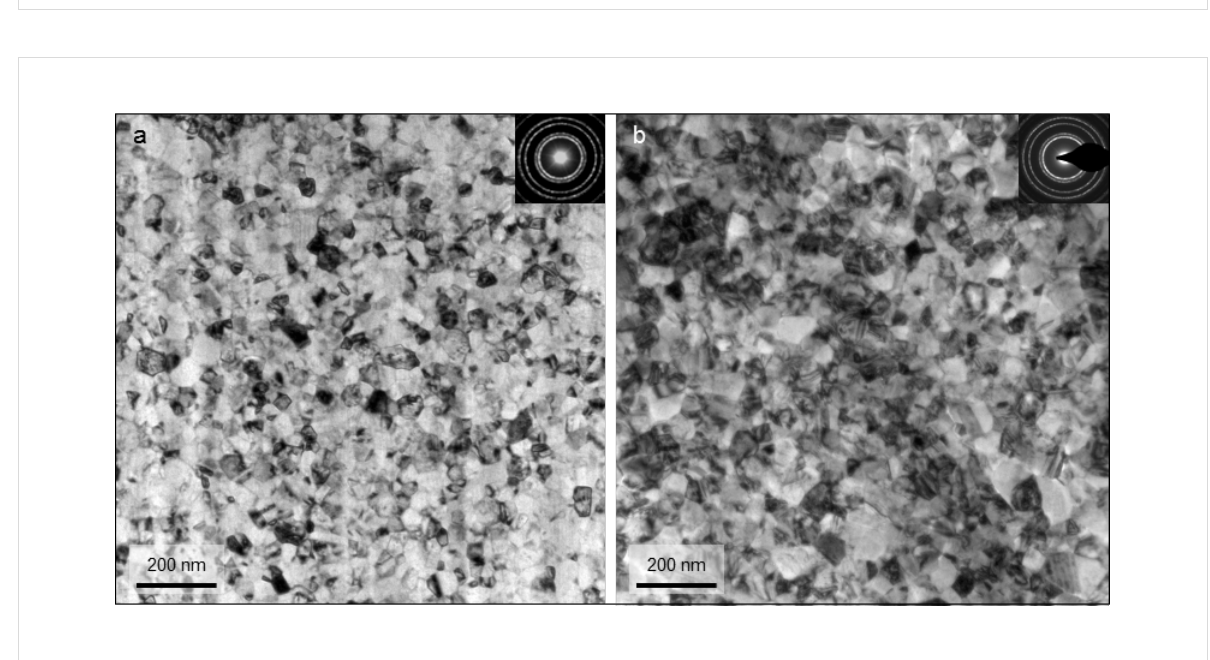
Figure 1: BF-TEM images of the initial microstructure of ncPd 1 (a) and ncPd 2 (b) with the corresponding selected electron diffraction pattern (SAED) as insets.